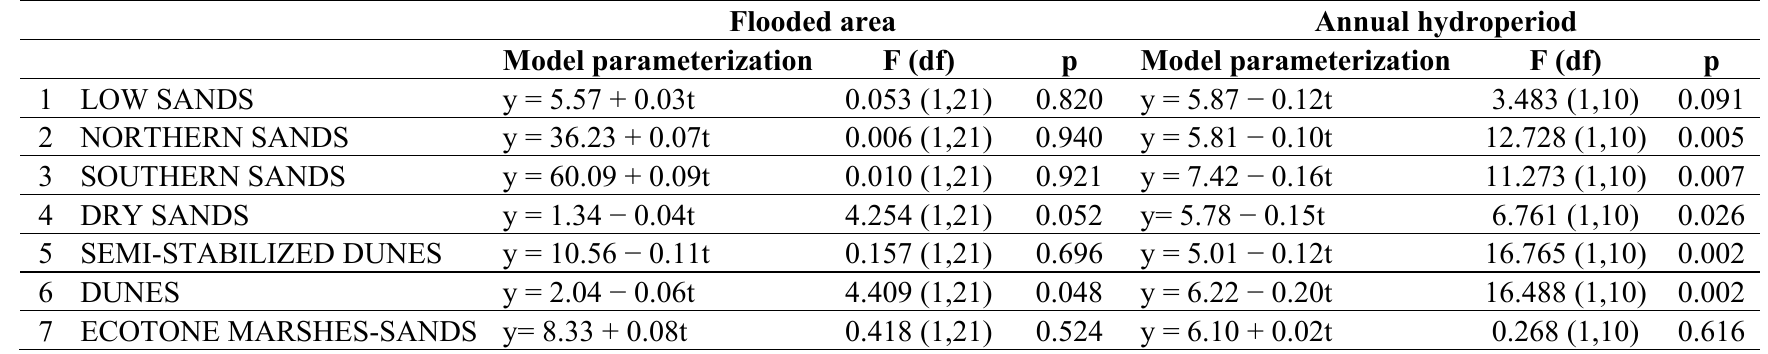
Table 4. Trend analysis of flooded area and annual hydroperiod in each ecosection. Model parameterization, where t corresponds to “time”, F statistics, degrees of freedom (df) and significance (p) are shown.